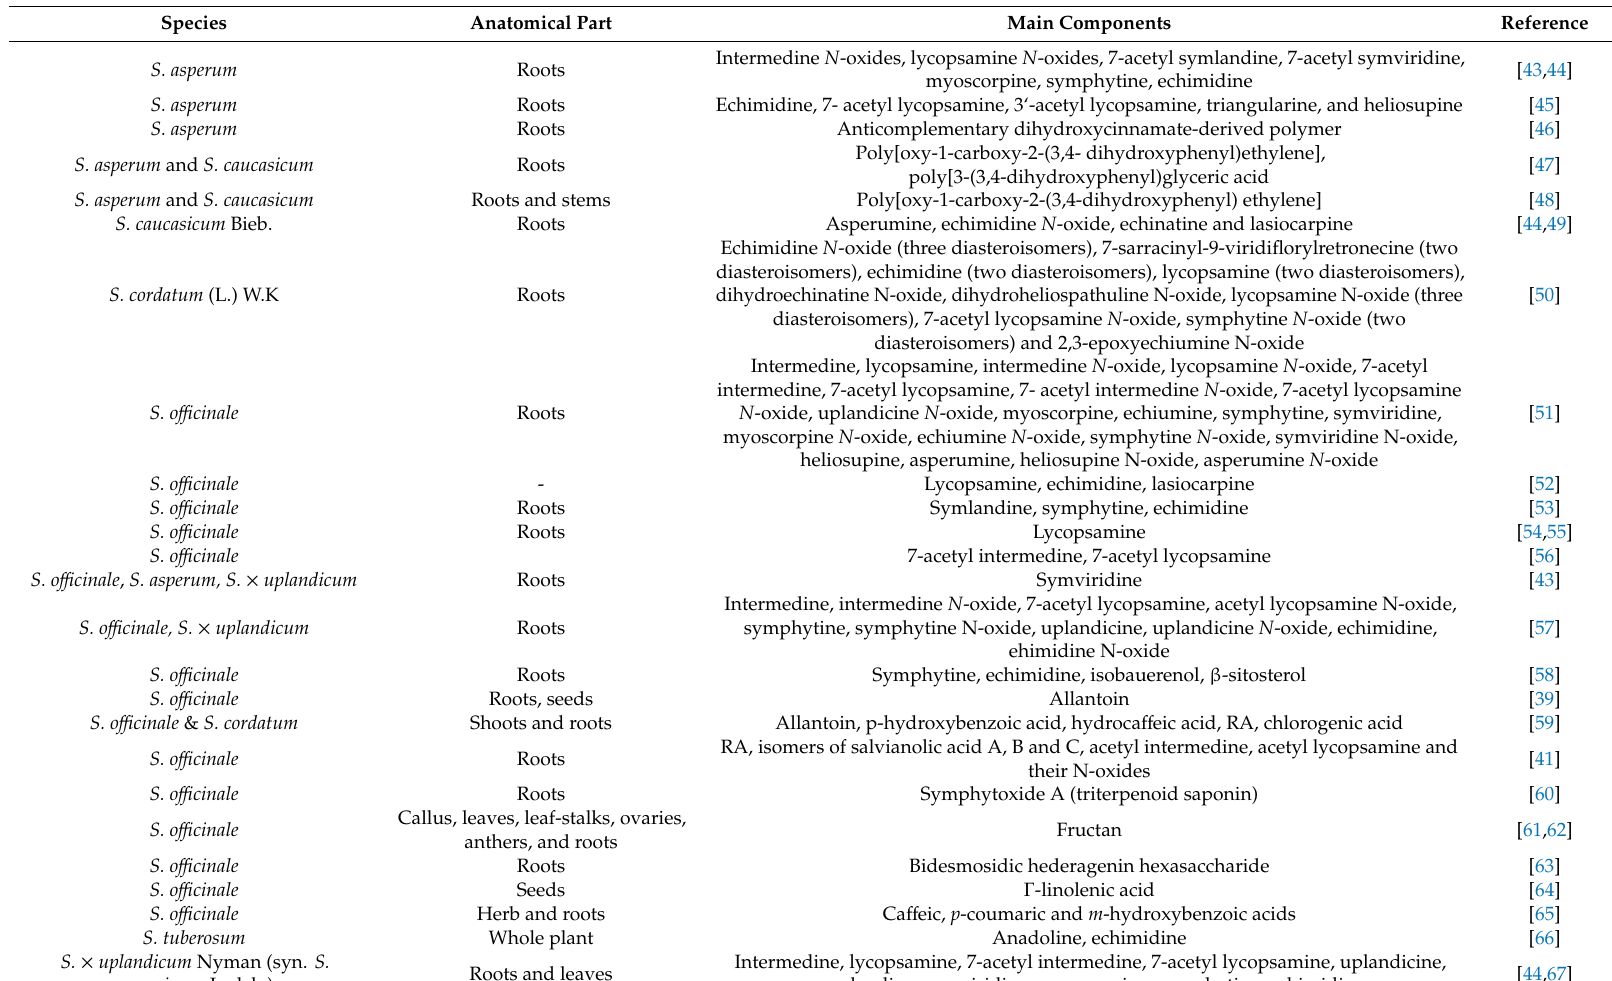
Table 1. A literature report on the main constitutions of Symphytum species from di ff erent geographical